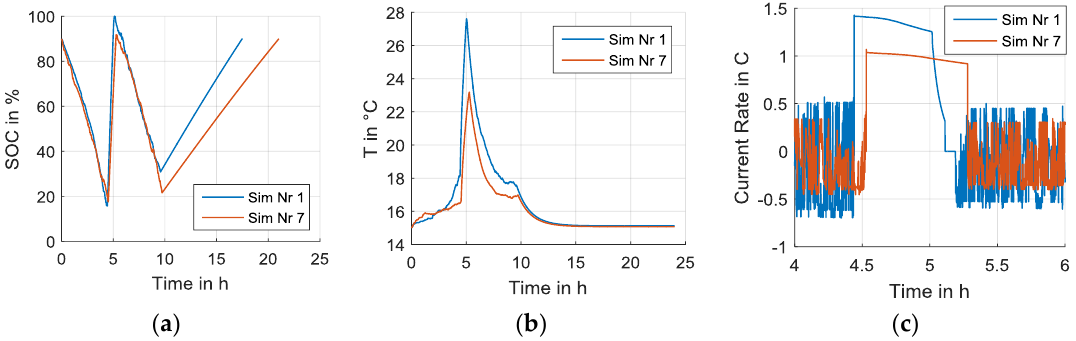
Figure 12. ( a ) SOC and ( b ) cell temperature for a daily driving sequence; ( c ) cell current rates during fast charging for Scenarios 1 and 7 (identical cell types but different transportation scenarios).